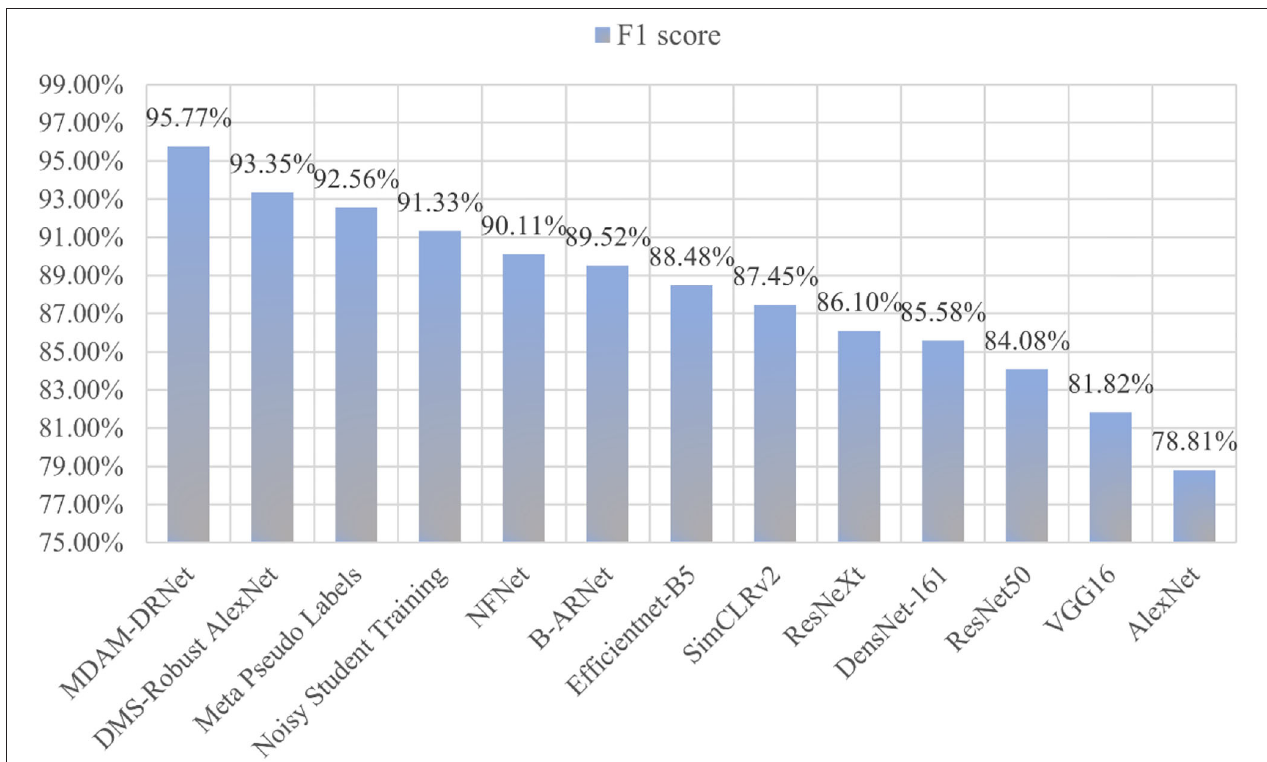
FIGURE 11 | F1 score histogram of each method.